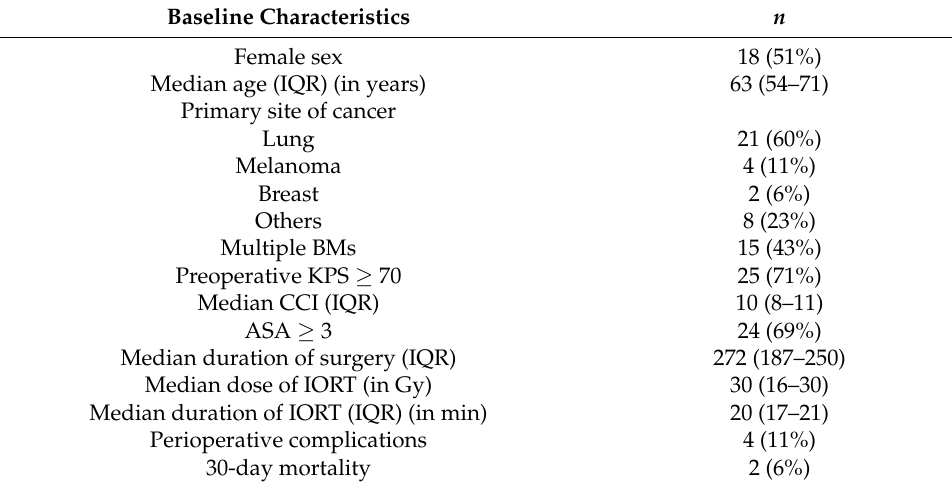
Table 1. Baseline characteristics of patients with